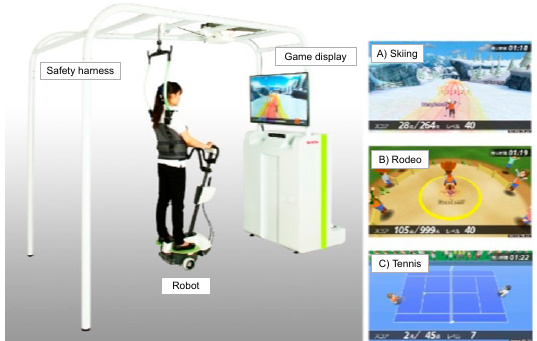
Figure 1. Balance Exercise Assist Robot (BEAR). The BEAR moves backward–forward and left–right according to shifts in the operator’s center of gravity. These movements can be incorporated into balance exercises by playing 3 games: ( A ) a skiing game, which involves using left–right movement; ( B ) a rodeo game, which requires responses to disturbance stimuli from the BEAR; and ( C ) a tennis game, which responds to forward–backward movement.